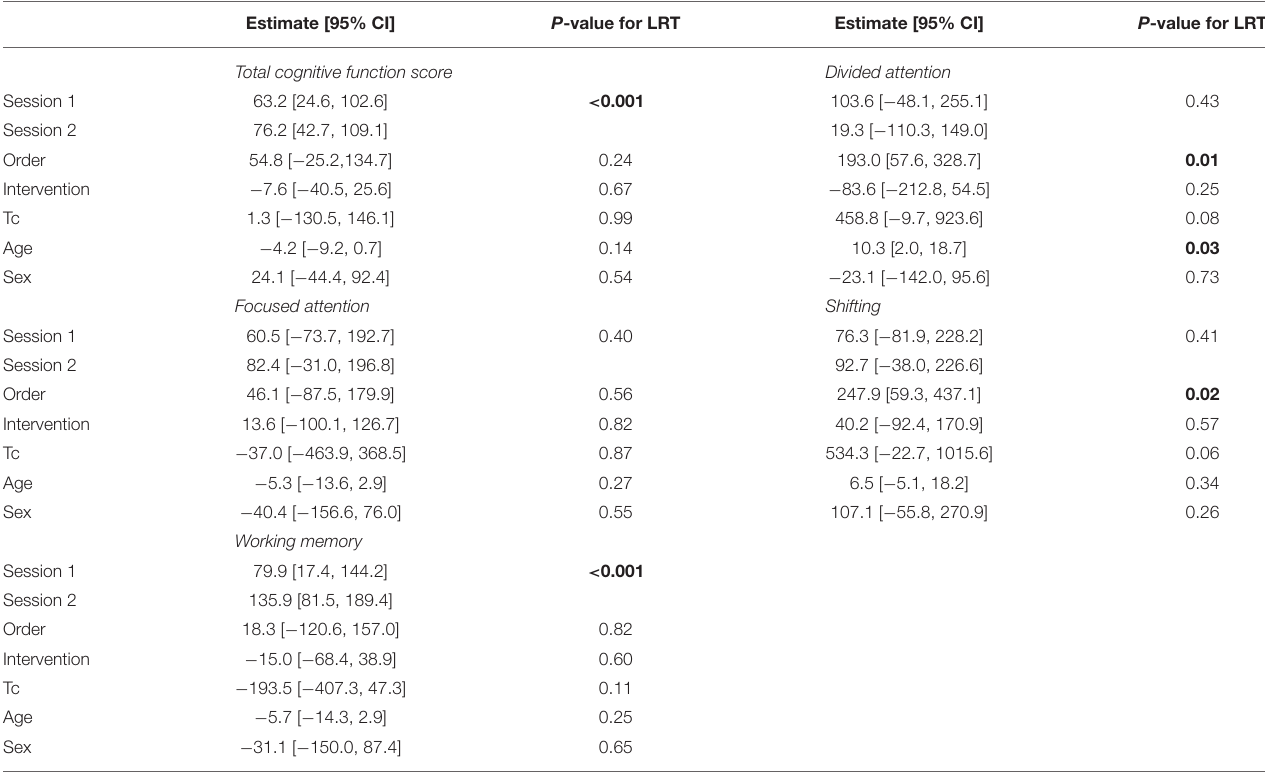
TABLE 3 | Linear multilevel model estimates for different cognitive